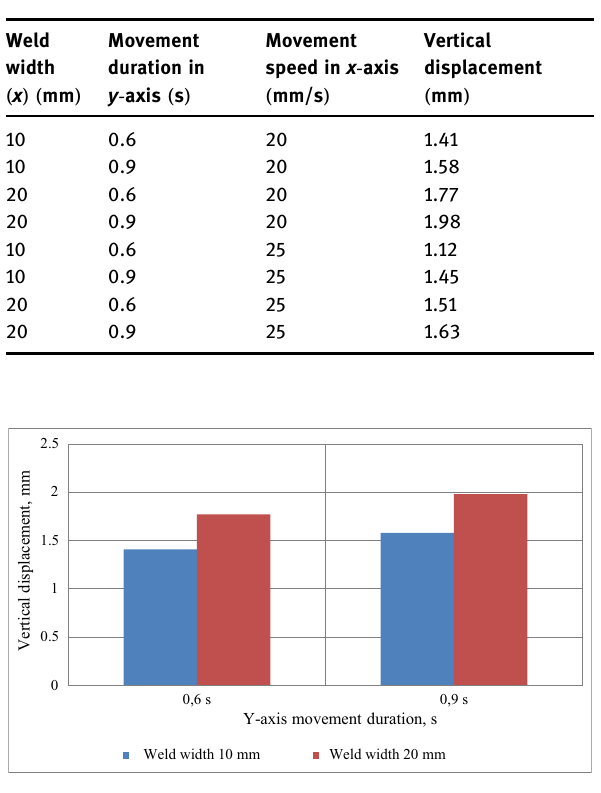
Figure 7: The e ff ect of weld width and y - axis movement duration on the angular distortion of plates welded with 20 mm/s x - axis welding